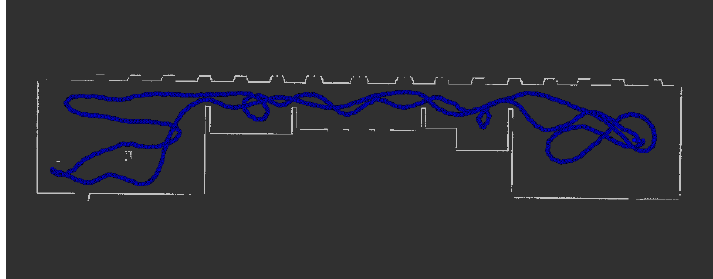
Figure 14. Room Segmentation Process in Scenario 2. Trajectory points in blue, detected doors in red.